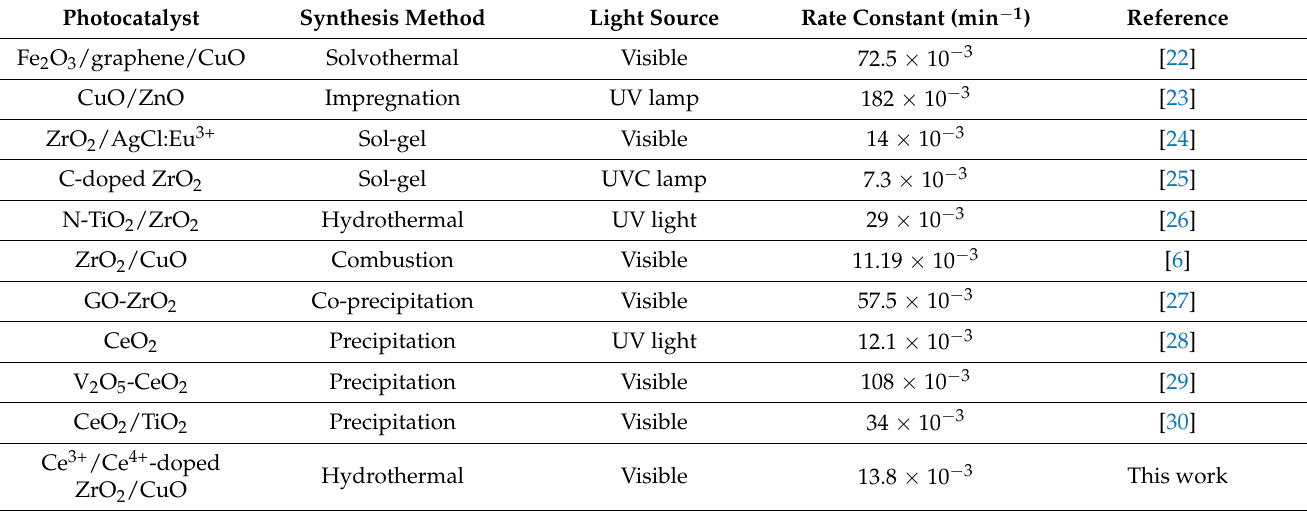
Table 1. Photocatalytic degradation of MB dye using the various heterojunction photocatalyst.